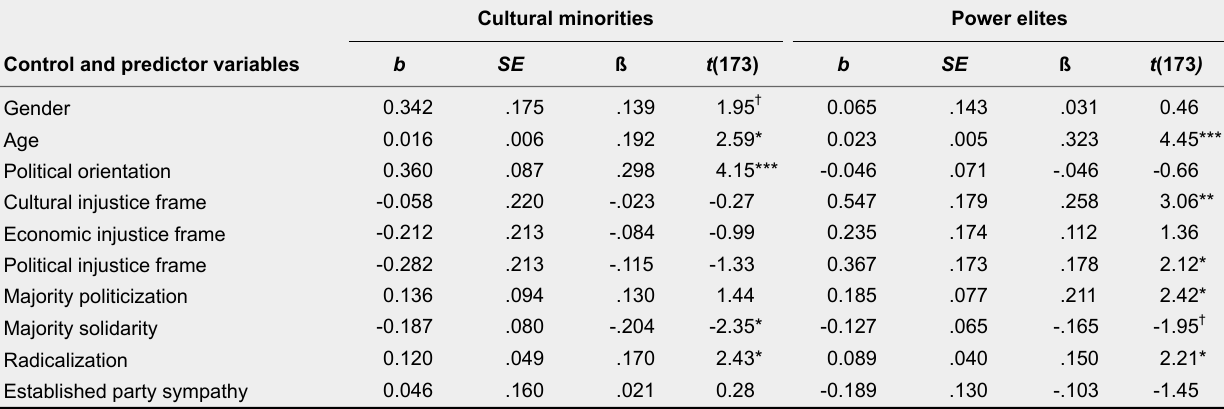
Multiple Regression Analysis With Negative Attitudes Toward Cultural Minorities and Power Elites as Criteria (Experiment